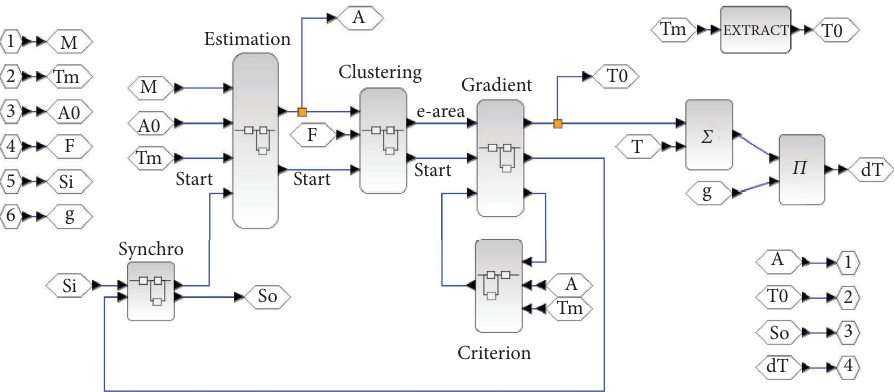
Figure 9: Superblock of the local